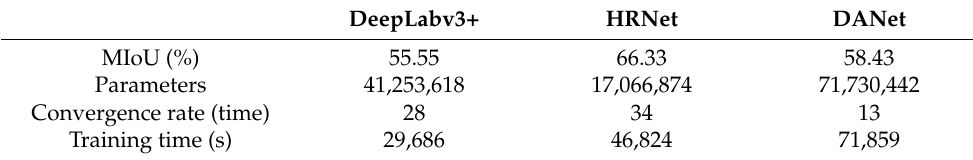
Table 2. Performance comparison of three semantic segmentation